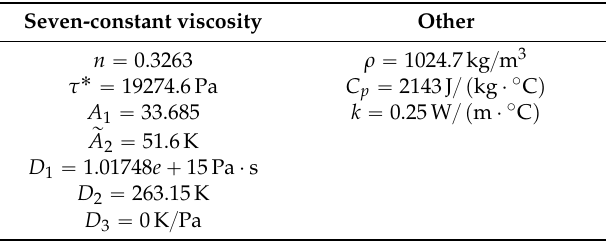
Table 1. Material parameters of polypropylene, Polyfort FIPP MKF 4025.